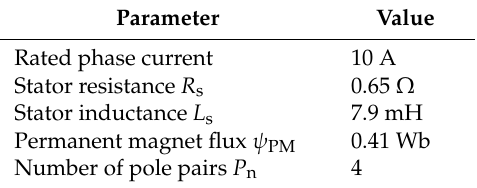
Figure 6. Simulation results of steady-state performance with sampling periods of ( a ) 25 μs , ( b ) 50 μs , and ( c ) 75 μs . Table 3. Parameters of a traction permanent magnet synchronous motor (PMSM).